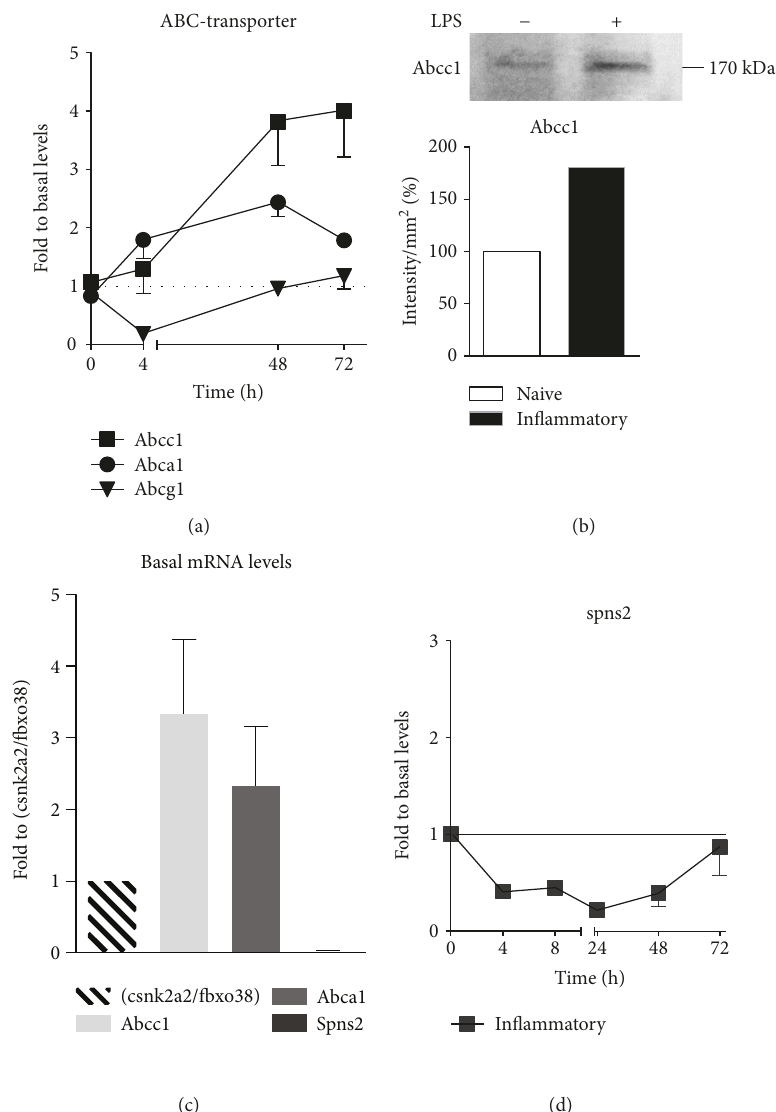
Figure 5: (a) Quantitative real-time PCR for abcc1, abca1, and abcg1 in LPS-stimulated dendritic cells over time normalized to the sum of csnk2a2 and fbxo38 mRNA levels. Levels at time point 0 were set to 1 for each mRNA ( n = 4 ). (b) Western blot stained with anti- Abcc1 antibody of whole-cell lysates of naïve dendritic cells or 48 h upon LPS stimulation. Quanti fi cation of Western blot bands ( n = 1 ). (c) Quantitative real-time PCR for abcc1, abca1, and spns2 in untreated dendritic cells ( n = 4 ). Displayed are absolute levels normalized to the sum of csnk2a2 and fbxo38 mRNA levels. (d) Quantitative real-time PCR for spns2 in LPS-stimulated dendritic cells over time normalized to the sum of csnk2a2 and fbxo38 mRNA levels. Levels at time point 0 were set to 1 ( n = 4 ). Data represent mean ±